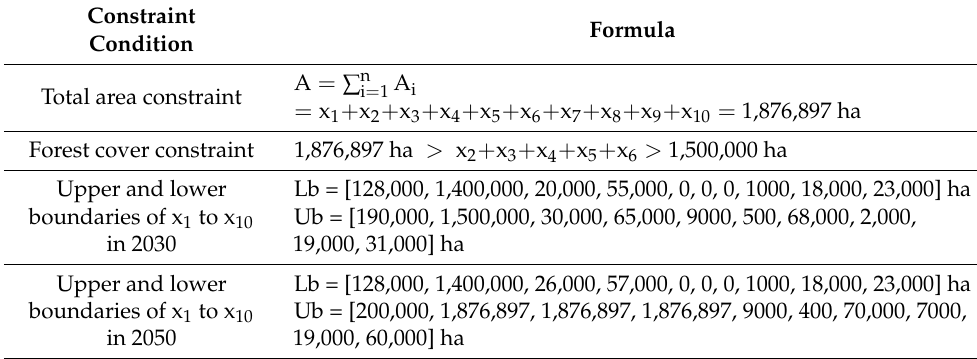
Table 3. Constraints and description of land use demand optimization